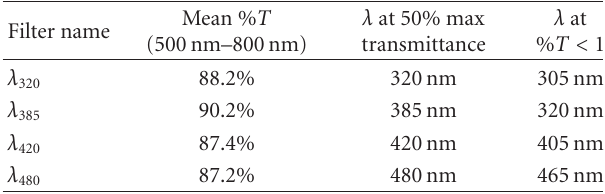
Table 2: Optical properties of polymer